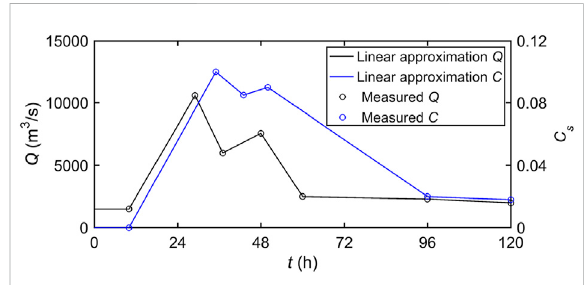
Flow discharge hydrographs and sediment concentration time series: Observed data and linear approximation at the Wubu station for a highly concentrated, sediment-laden fl ood lasting from 8:00 a.m. on July 26 to 8:00 a.m. on 31 July 2012, and two fl ood peaks caused by secondary